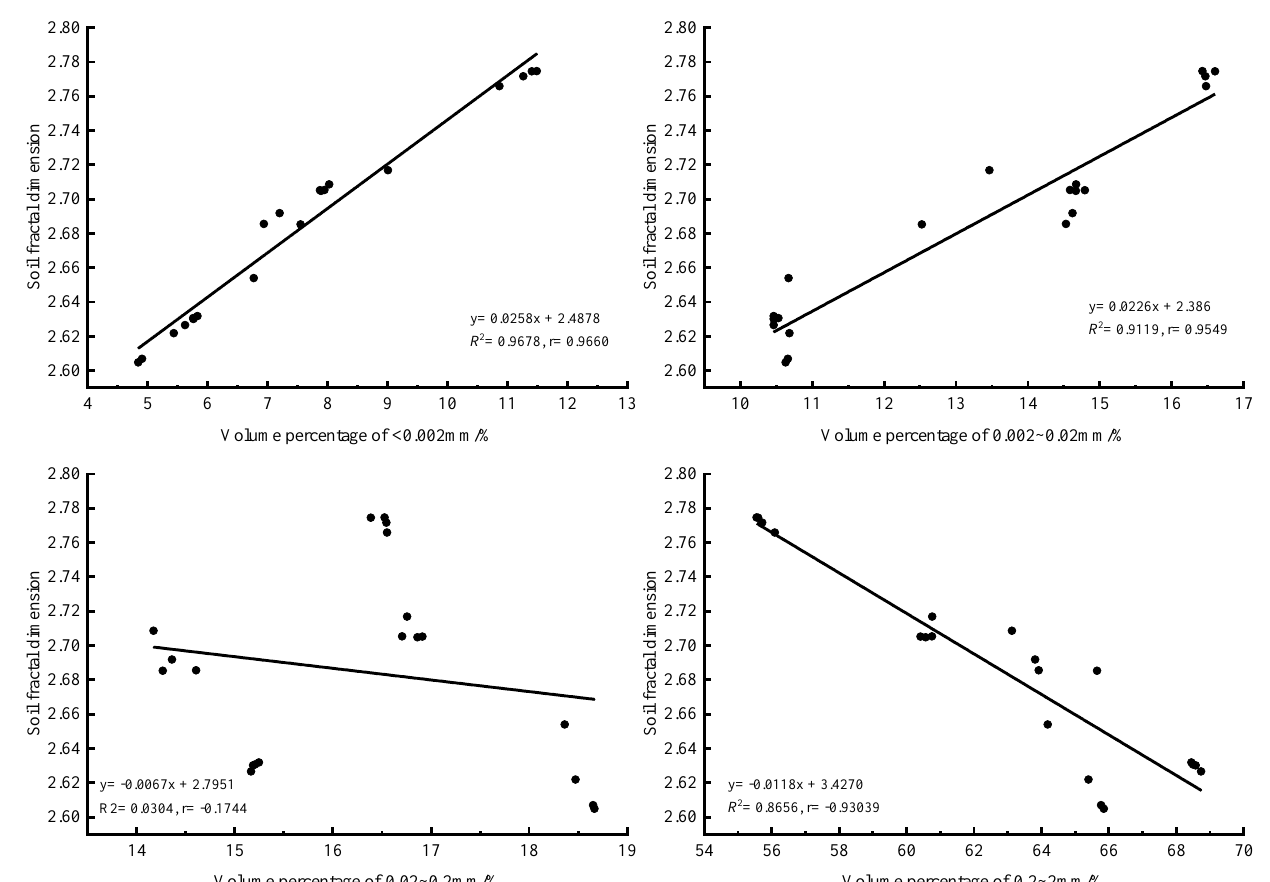
Figure 8. Correlation changes between soil particle size and fractal dimension.